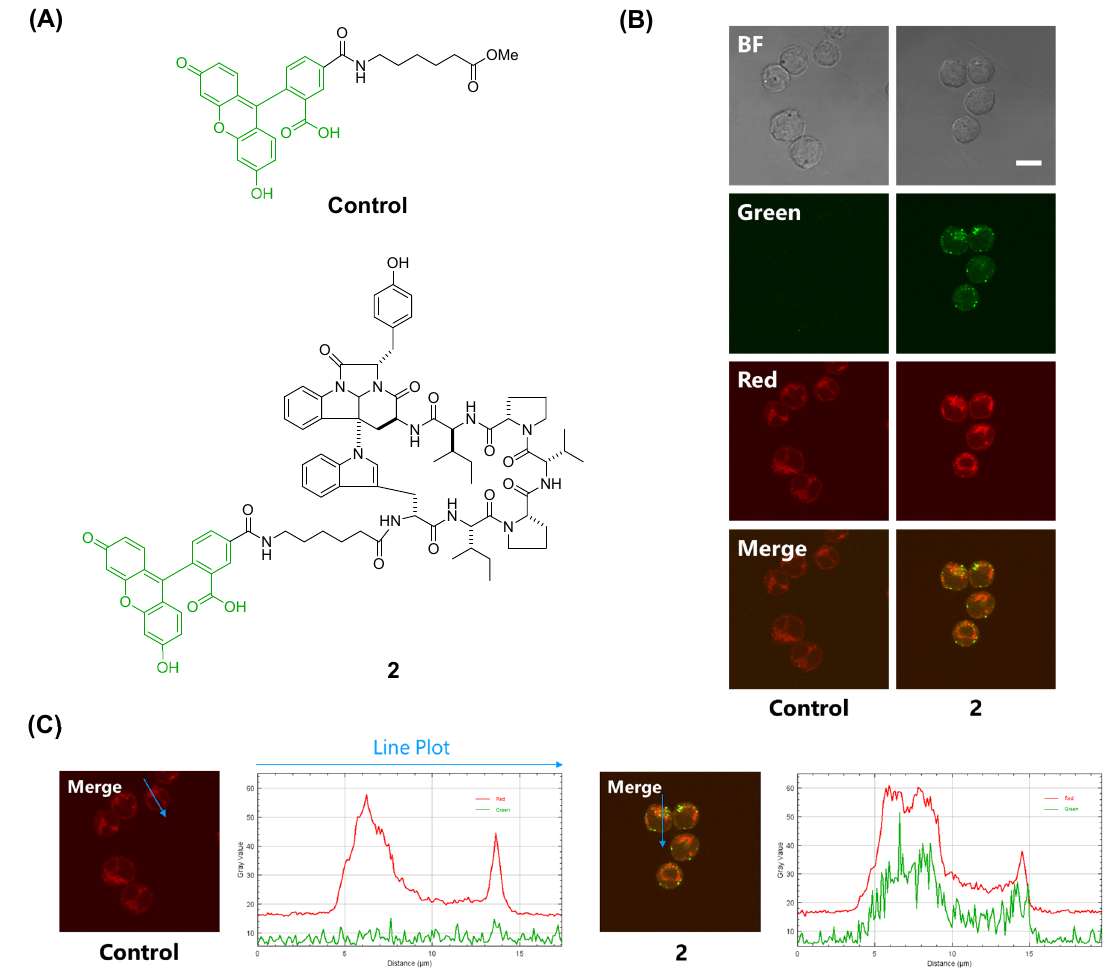
Figure 2. Co-localization studies in P388 cells. ( A ) Structures of the fluorescent probes. ( B ) Confocal microscopy images of P388 cells incubated with 2 with Lipofectamine 2000 for 2 h (green). During the incubation, the live cells were stained with MitoTracker (red). Magnification × 100, scale bar: 20 µ m. The brightness and contrast were equally adjusted for all the green and red fluorescence images. ( C ) Co-localization analysis of P388 cells. The line profile plots analysis using Image J showed the green and red fluorescence intensity distribution through the blue